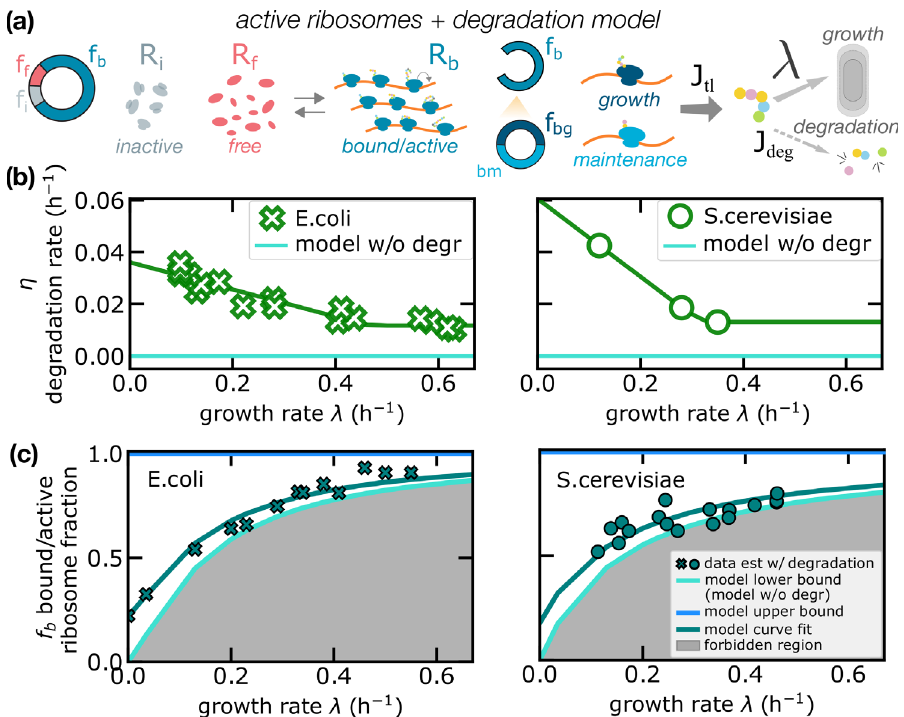
Fig 4. Protein degradation increases the fraction of active ribosomes. (a) Sketch of the second model of protein production proposed in this work, which includes both protein degradation and inactive ribosomes. In this model, only some ribosomes contribute to net protein synthesis. As the model in Fig 3, proteins can be lost by protein degradation or diluted by cell growth. (b) Experimental data on mean degradation rates across conditions for E. coli from [38] and for S. cerevisiae from [42]. The green line is a piece-wise linear fit of the data (see Materials and methods) and the cyan line represents the degradation for the standard model ( η = 0). (c) Estimated fraction of active ribosomes in the combined model (turquoise symbols) compared to the model neglecting degradation rates (solid line —lower bound). In absence of degradation, the fraction of active ribosomes is estimated from Eq (1), f ¼ l . In b g � R presence of degradation, Eq (12) gives f ¼ l þ Z . Turquoise symbols (crosses for E. coli , circles for S. cerevisiae ) b g � R g � R show the estimates from these formulas for experimental values of the other parameters. The model lower bound (solid line above the shaded area) for the fraction of active ribosomes is the prediction of the active ribosome model, but incorporating the non-null measured degradation rates in these estimates determines considerable deviations from this bound, validating the joint model. Continuous lines are analytical predictions with the constant ratio ansatz, Eq (14). For E. coli , estimates are performed using data for ribosome fractions ϕ and translation rate γ from [5] and R degradation rates η from [38]. For S. cerevisiae , estimates are performed using data for ribosome fractions and translation rate from [4] and degradation rates from